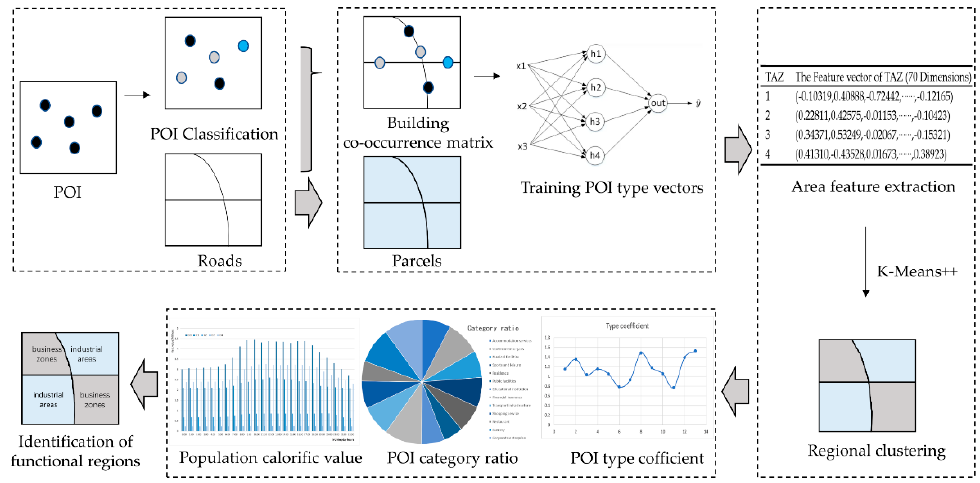
Figure 3. Flowchart of urban functional area identification.